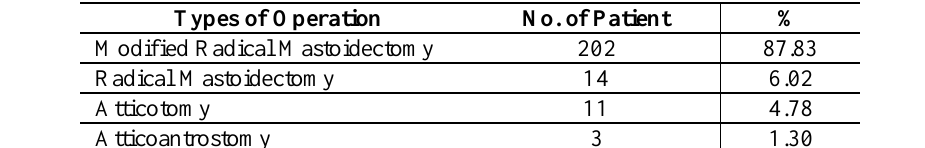
Table I : Types of operation (n=230)